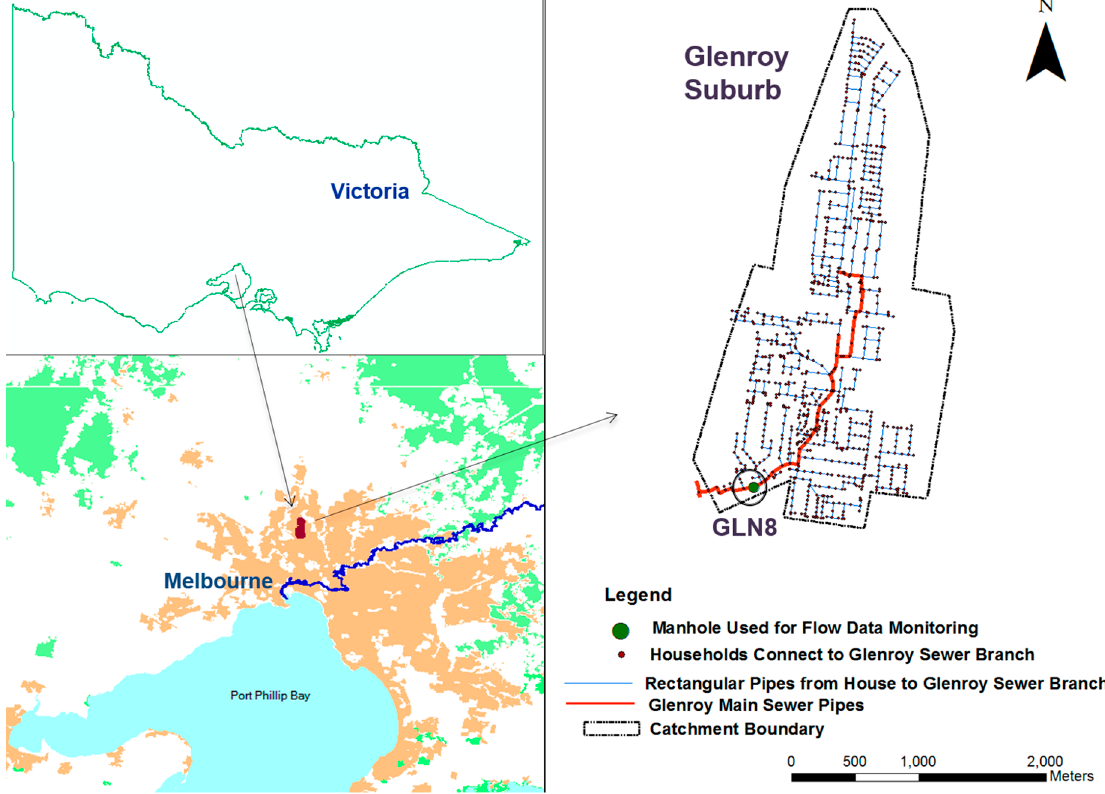
Figure 2. Location of the Glenroy sewershed in Melbourne.